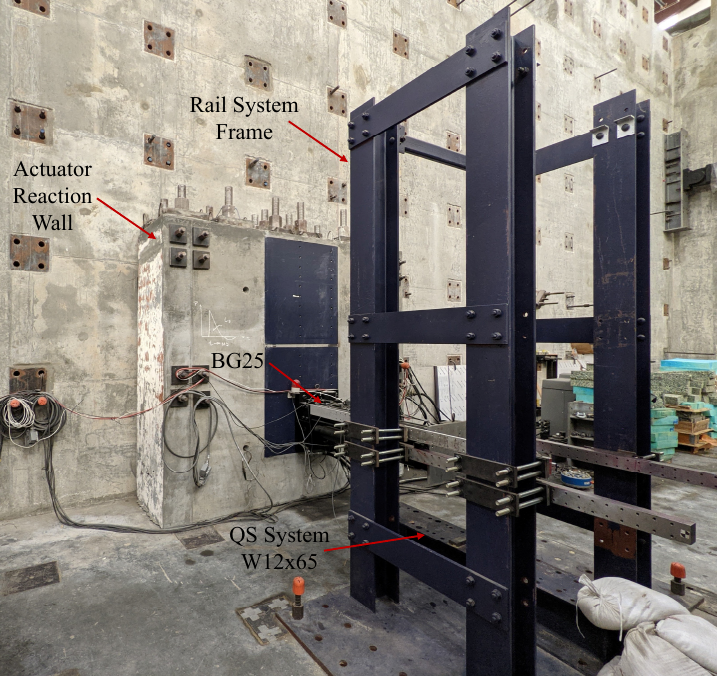
Figure 3. Impact